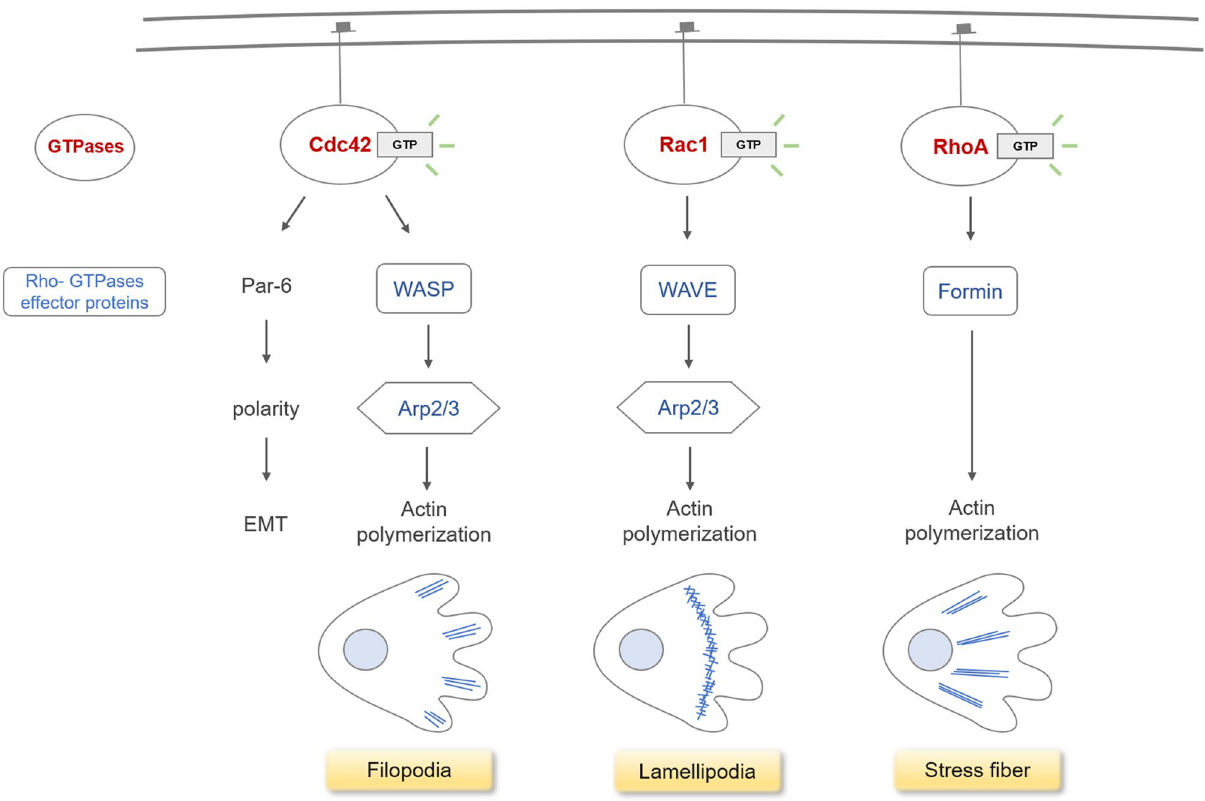
Figure 5. Formation pathway of cytoskeleton structure by F-actin. Filamentous actin is the major cytoskeletal protein in the cell, and there are three main structures formed by F-actin within a cell: filopodia, lamellipodia, and stress fiber. The Rho GTPases Cdc42, Rac1, RhoA are key elements in the regulation of actin filaments. Cdc42 and Rac1 induce actin polymerization through the WASP/WAVE family members, which are